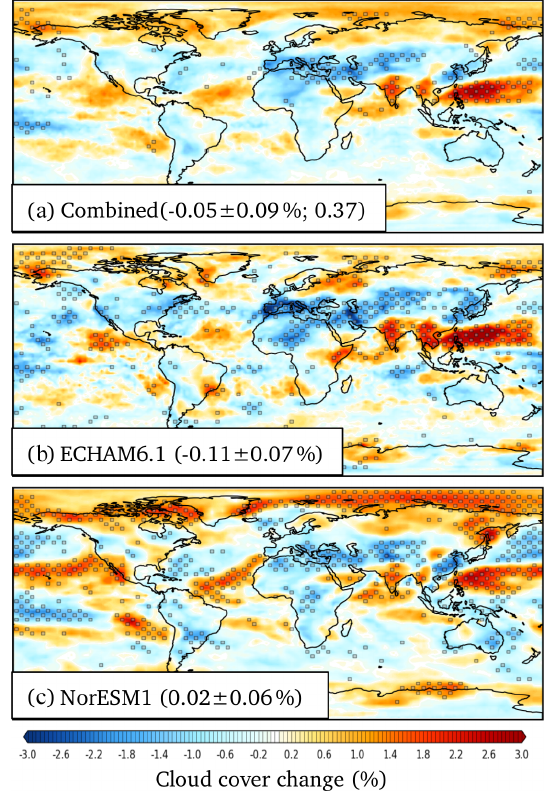
Figure 3. The geographical distributions of annually averaged changes in total cloud cover due to the removal of South and East Asian aerosols. (a) Cloud cover change averaged over both ECHAM6.1 and NorESM1 climate models. Brackets show global average responses in percentages and the model-to-model correla- tion coefficient, respectively. Stippling shows regions where the re- sults are statistically significant at the p < 0 . 05 level for both mod- els, and models also agree on the sign. ( b , c ) Cloud cover change in ECHAM6.1 and NorESM1, respectively. Brackets give global av- erage responses in percentages. Stippling shows regions where the results are statistically significant at the p < 0 . 05